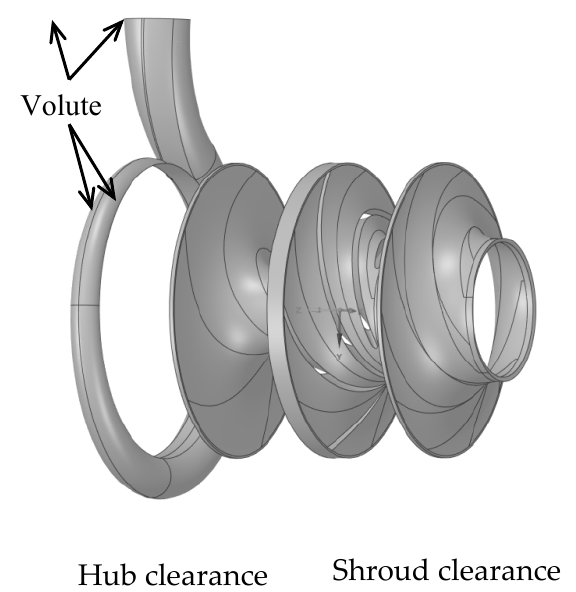
Figure 1. Computational flow domain of centrifugal pump. Table 2. Reference pump dimensions.